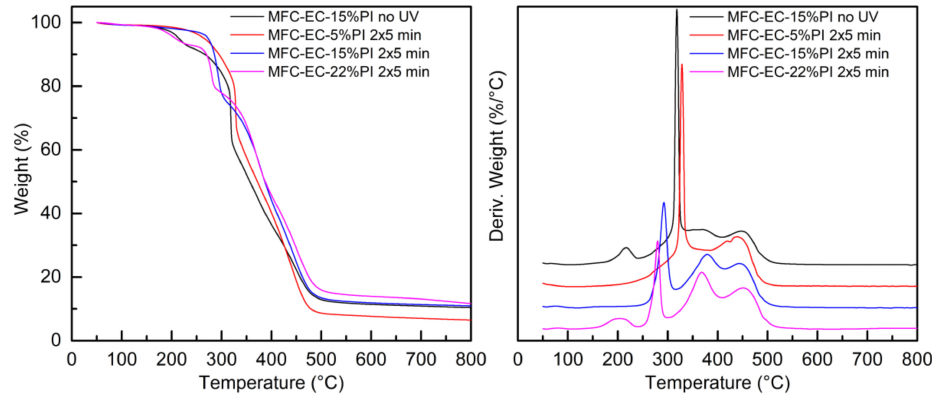
Figure 10. Weight (right) and derivative of the weight (left) as a function of temperature for uncured and cured